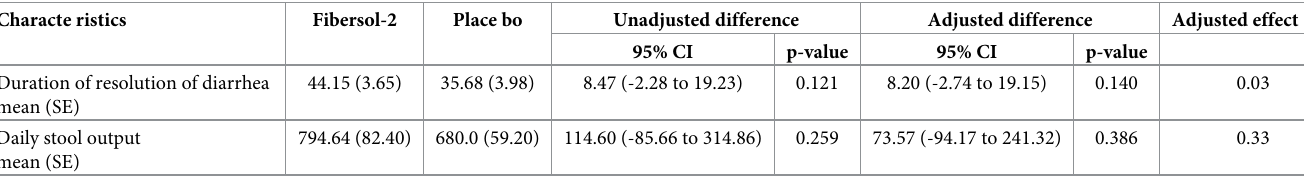
Table 3. Regression analysis for continuous outcomes.